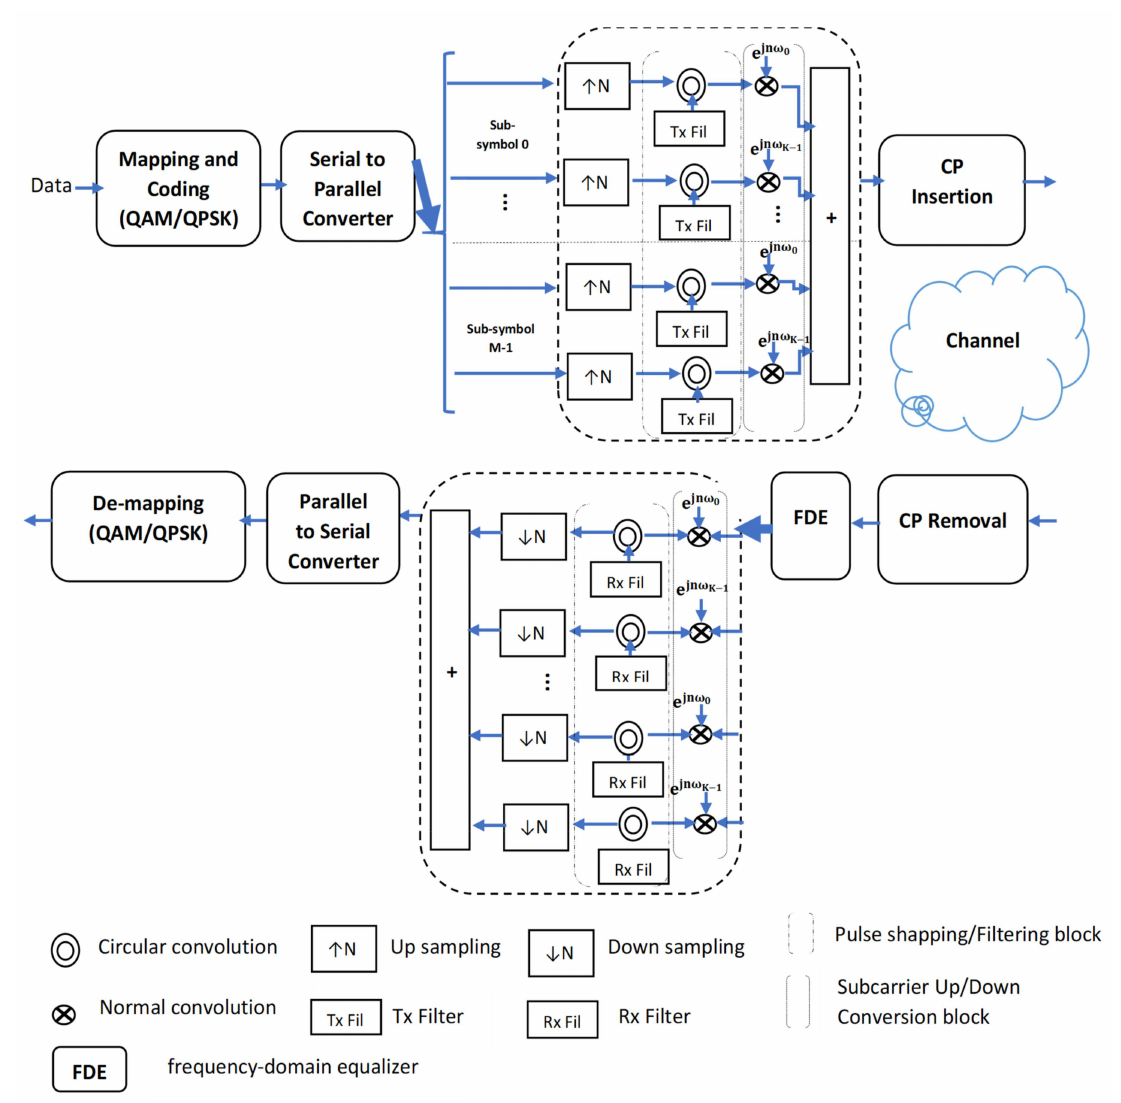
Figure 8. GFDM transceiver: the GFDM modulator consists of two stages, pulse shaping and subcarrier up-conversion. In the demodulator, those operations are inversed: subcarrier down- conversion and